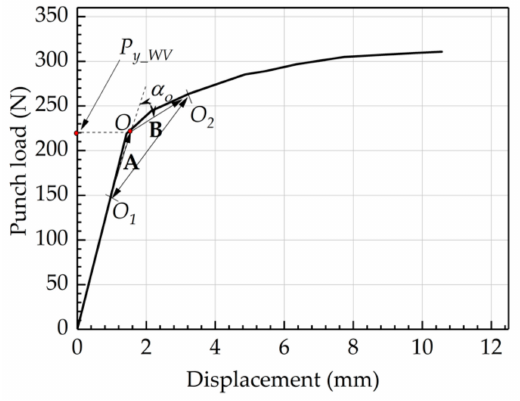
Figure 8. WV method.